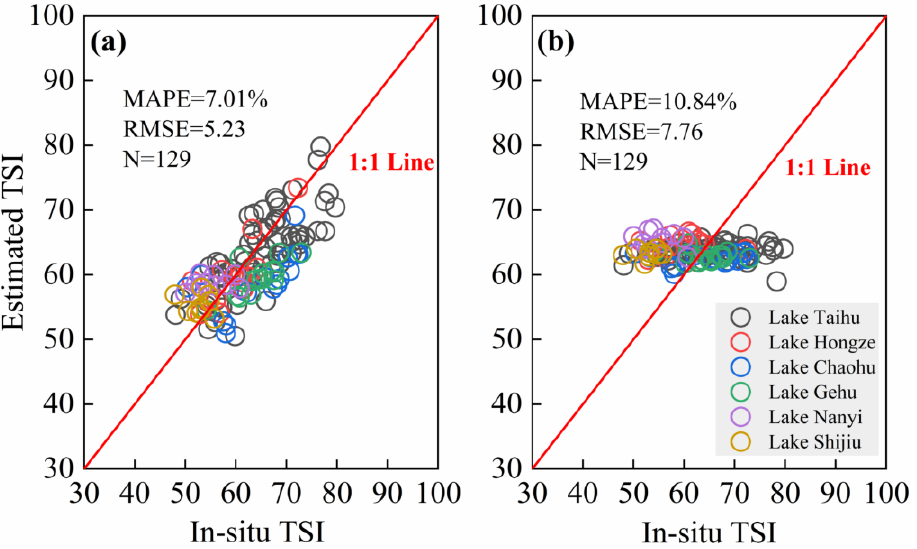
Figure 5. ( a ) Comparison of in-situ TSI and estimated TSI based on our study; ( b ) Comparison of in-situ TSI and estimated TSI based on the algorithm of Shi.